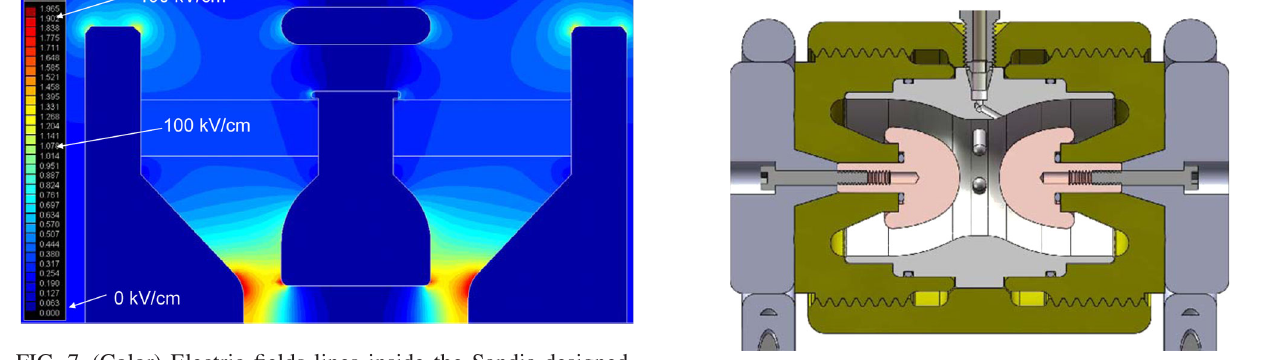
FIG. 8. (Color) Cross-sectional view of the gas switch designed by Kinetech, LLC.